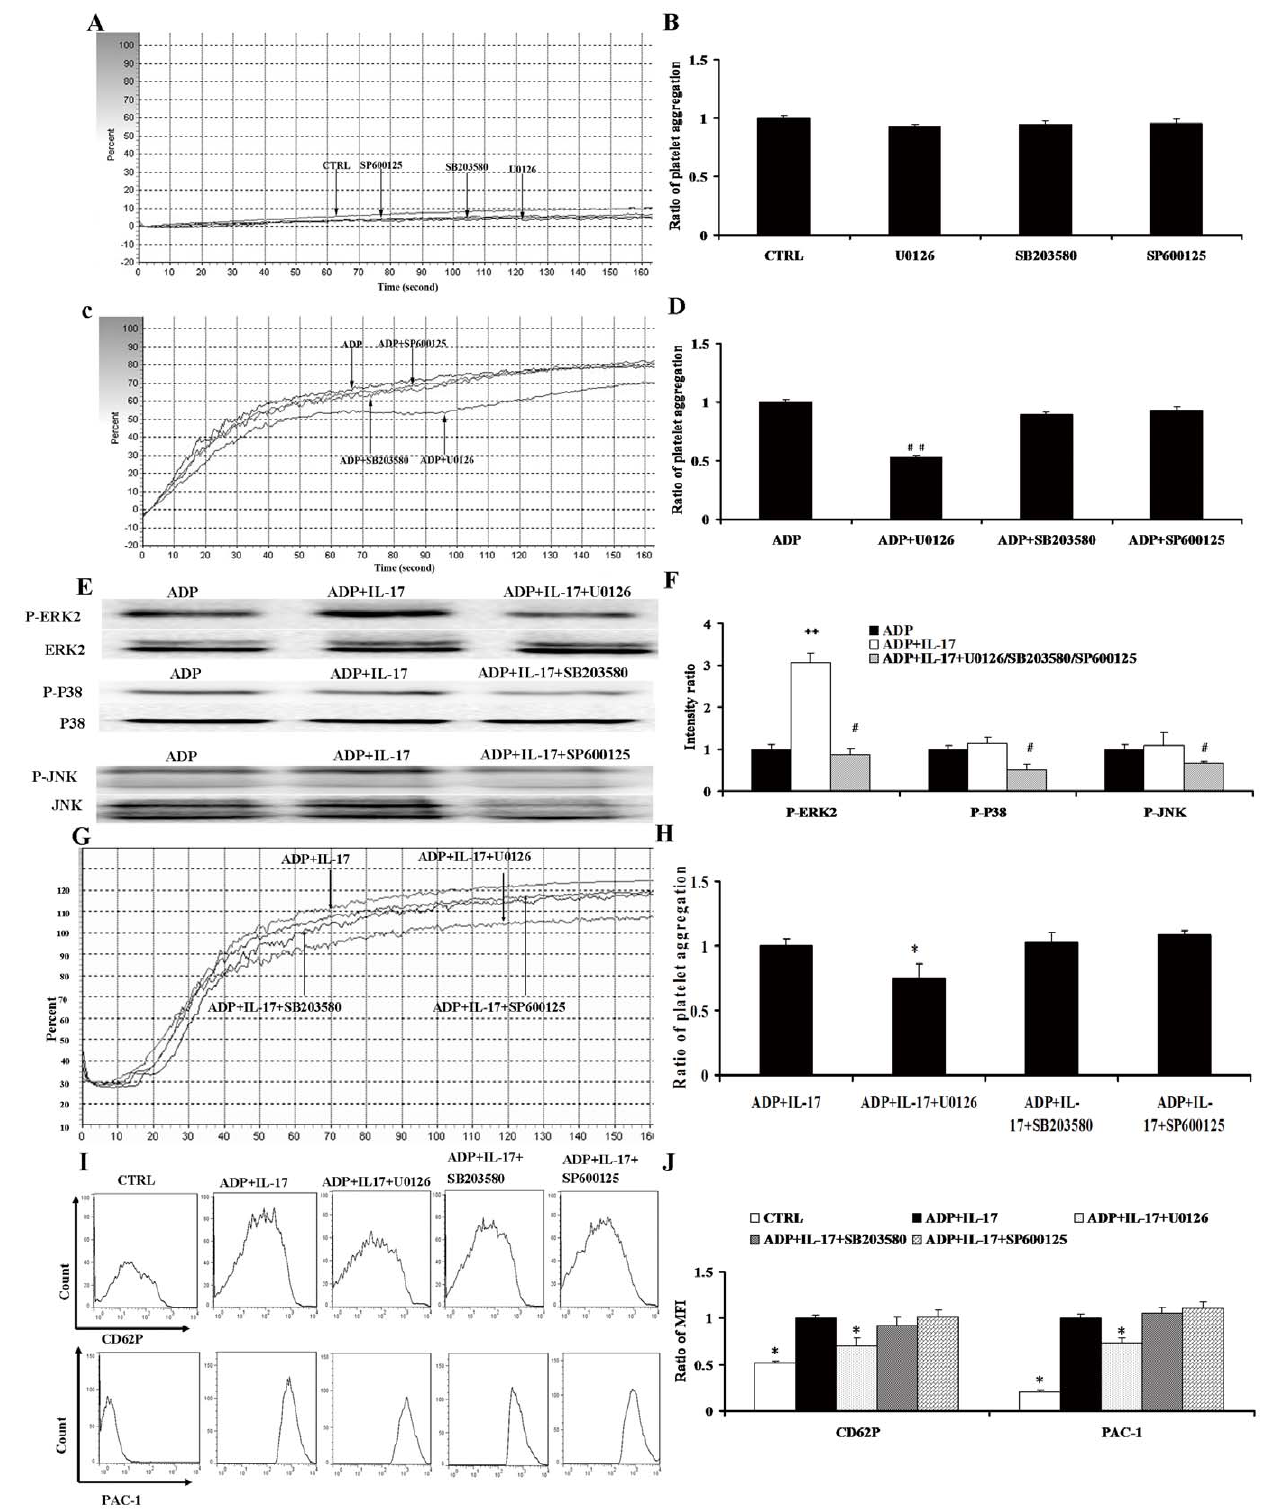
Figure 5. The effect of MAPKs inhibitor on platelet aggregation mediated by IL-17A combined with ADP. (A) Representative pictures for platelet aggregation response to U0126, SB203580, SP600125 and CTRL (without any intervention). (B) The results of statistical analysis for ratio of platelet aggregation response to U0126, SB203580, SP600125 and CTRL (without any intervention). (C) Representative pictures for platelet aggregation response to ADP and ADP + U0126/SB203580/SP600125. (D) The results of statistical analysis for ratio of platelet aggregation response to ADP and ADP + U0126/SB203580/SP600125. (E) The levels of MAPKs phosphorylation were measured using Western blot analysis in ADP, ADP + IL-17A and ADP + IL-17A + U0126/SB203580/SP600125 group. (F) The results of statistical analysis for the MAPKs phosphorylation in ADP, ADP + IL-17A and